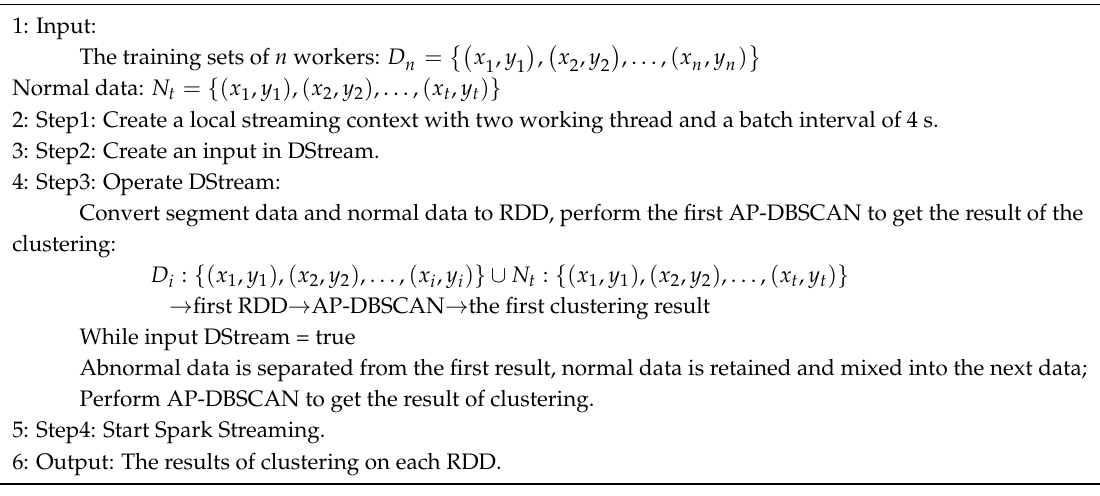
Algorithm 1. Main steps in AP-DBSCAN on Spark